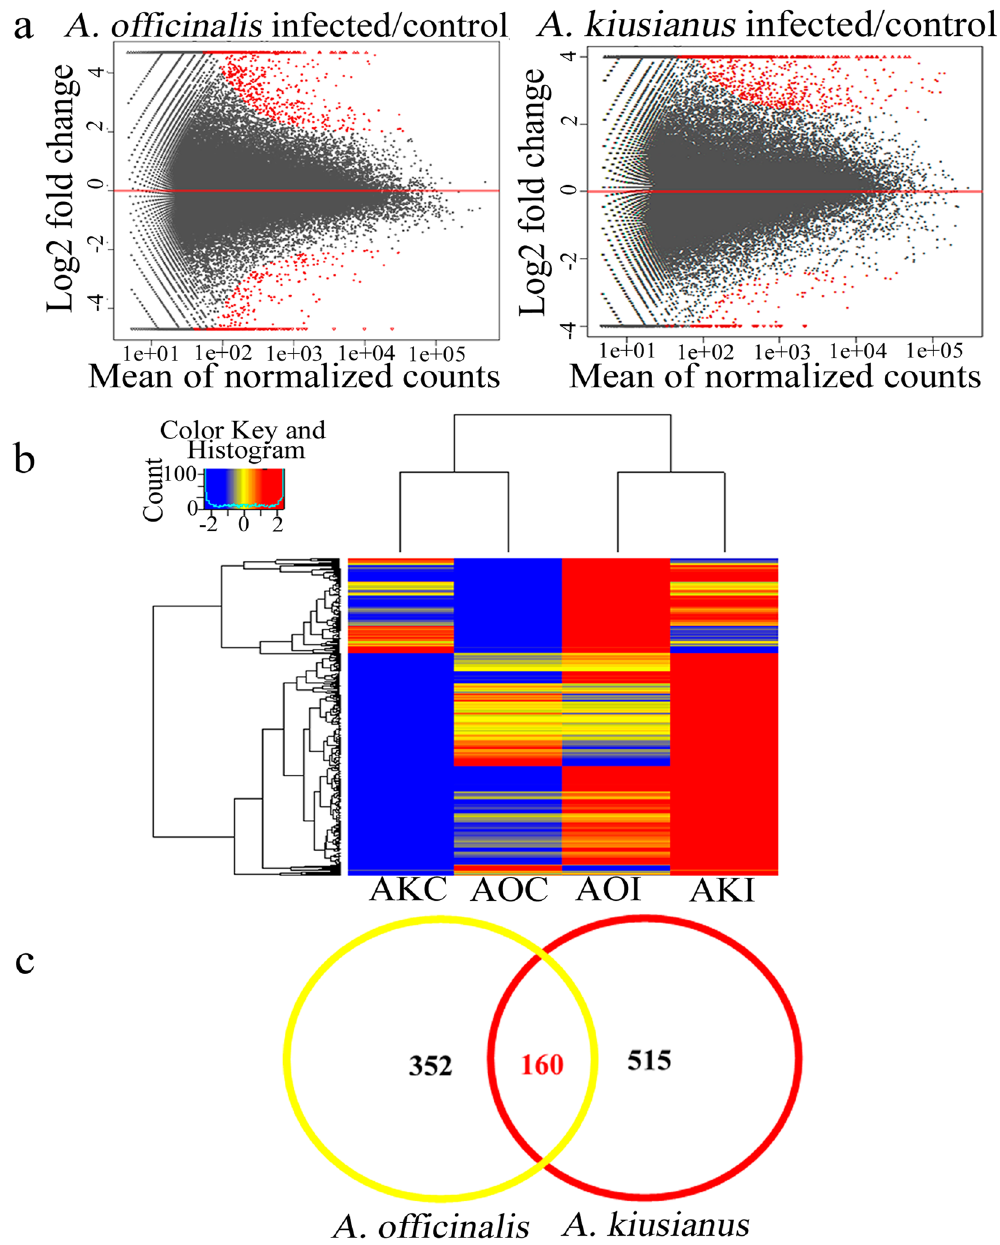
Figure 4. Differentially expressed genes (DEGs) in Asparagus officinalis and A . kiusianus stems 24 h after inoculation with Phomopsis asparagi . ( a ) MA scatter plot analysis showing log 2 fold change (y-axis) of pairwise comparisons between A . officinalis inoculated with P . asparagi (infected) versus A . officinalis treated with sterile distilled water (control), and A . kiusianus inoculated with P . asparagi (infected) versus A . kiusianus treated with sterile distilled water (control). DEGs are highlighted in red. ( b ) Heatmap clustering of up-regulated transcripts (fold change ≥ 2) in A . officinalis inoculated with P . asparagi (AOI) relative to A . officinalis treated with sterile distilled water (AOC), and A . kiusianus inoculated with P . asparagi (AKI) relative to A . kiusianus treated with sterile distilled water (AKC). ( c ) Venn diagram of transcripts up-regulated in A . officinalis and A . kiusianus 24 h after inoculation with P . asparagi